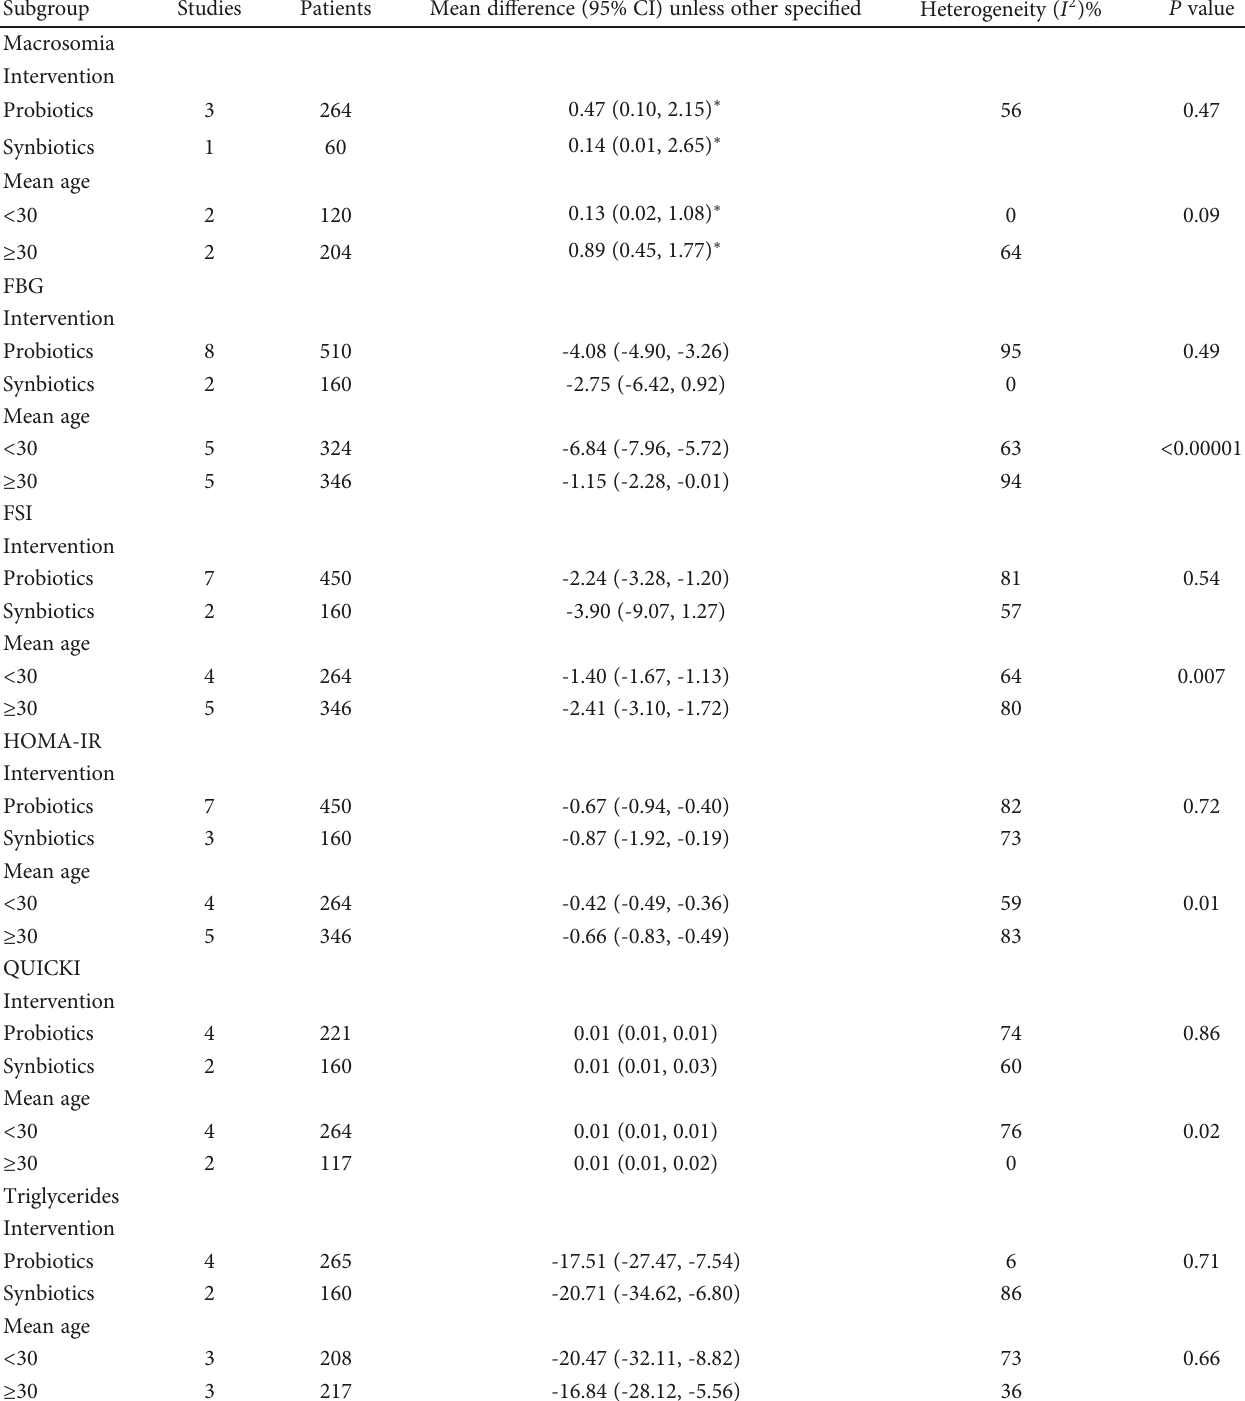
Table 2: The results of subgroup analysis according to intervention type and